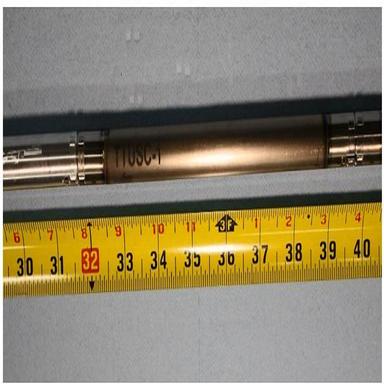
Photograph of the TTUSC experiment stack up.